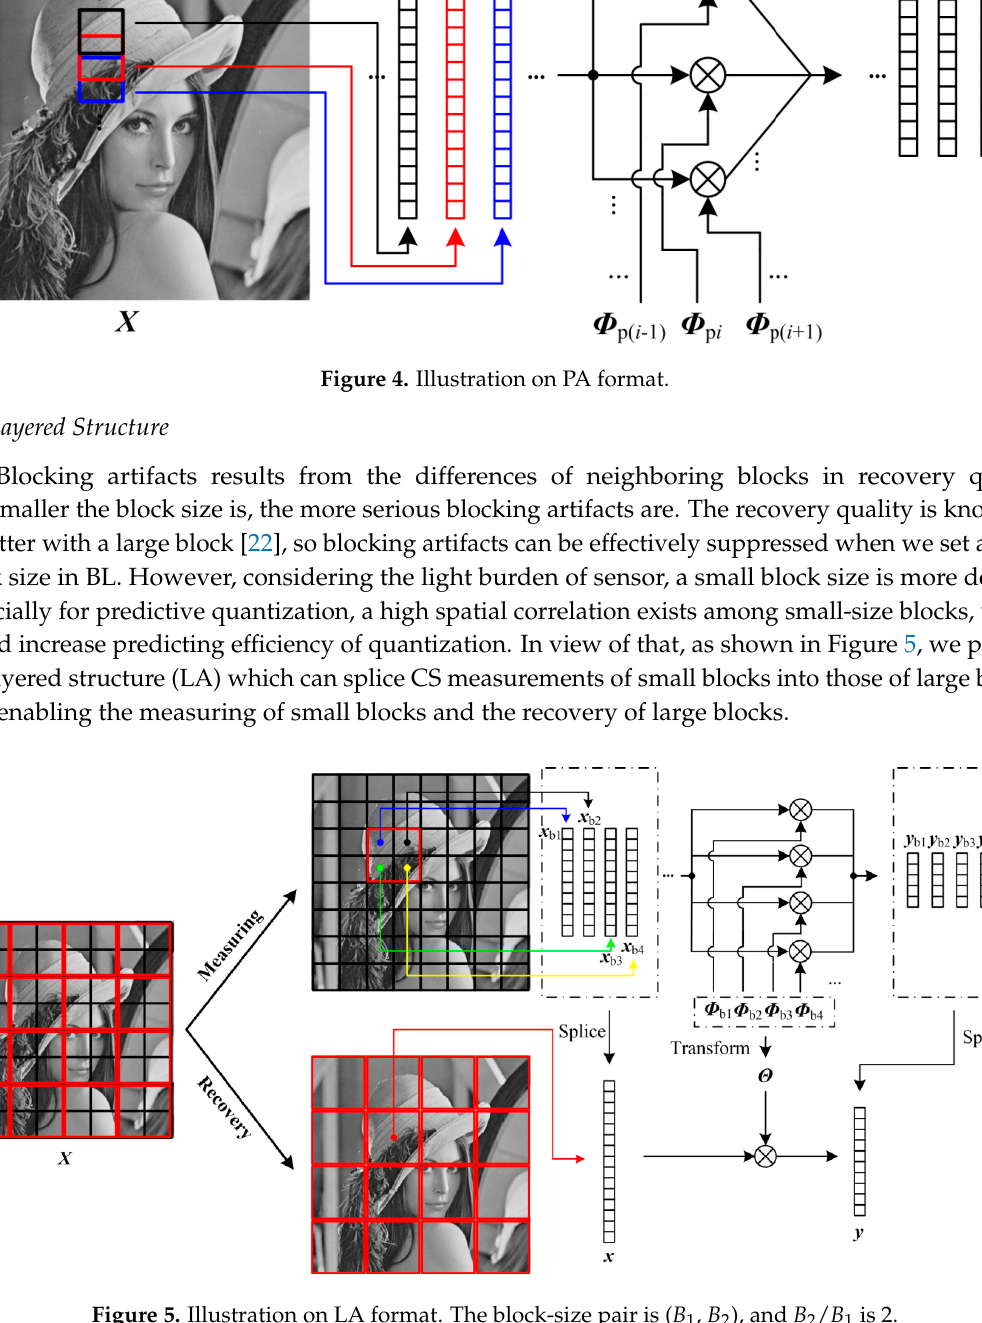
1 , B 2 ), and B 2 / B 1 is